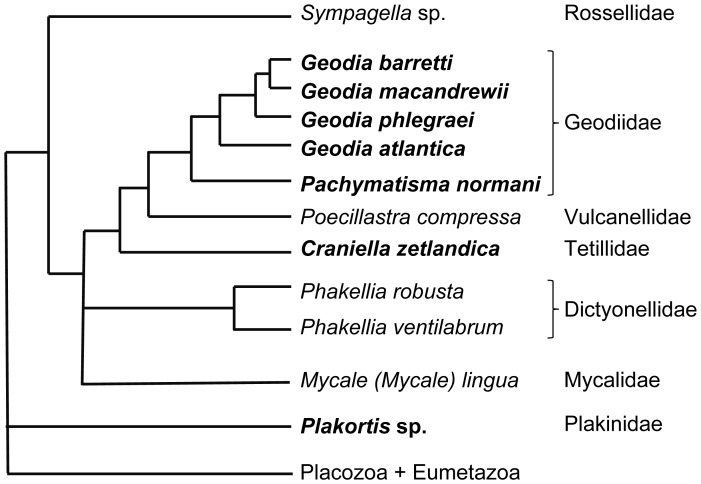
Sponge phylogenetic relationships.The tree topology represents a synthesis of phylogenetic reconstructions from [66], [74]–[75], showing the twelve sponge species from eight different sponge families targeted in this study. Bold: high microbial abundance (HMA) sponges; non-bold: low microbial abundance (LMA) sponges. The concept of LMA and HMA sponges does not follow a phylogenetic trend.